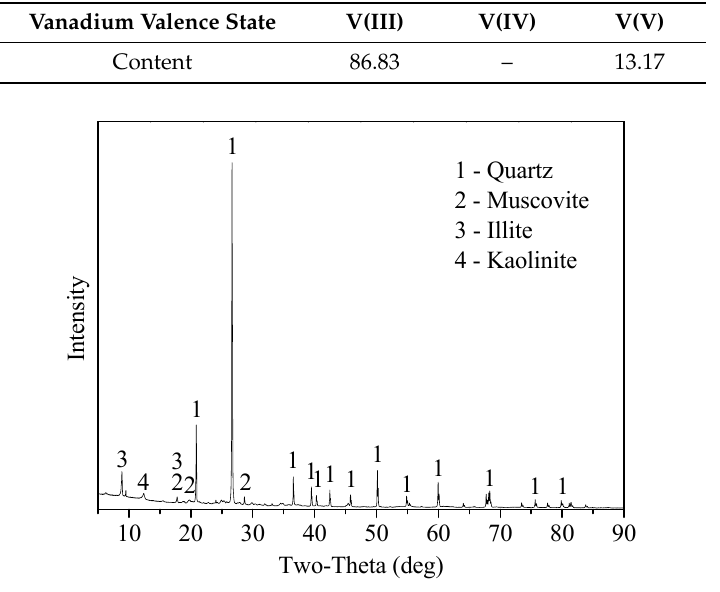
Figure 1. The XRD pattern of raw ore.